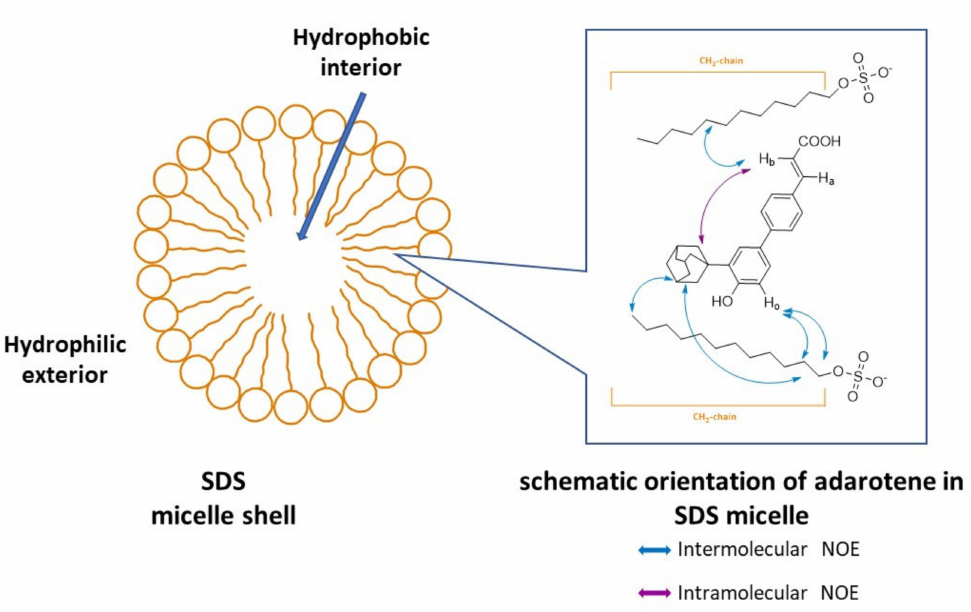
Figure 5. Schematic representation of the NOEs observed in 2D ROESY spectrum of adarotene + SDS micelles in D 2 O, T = 25 ◦